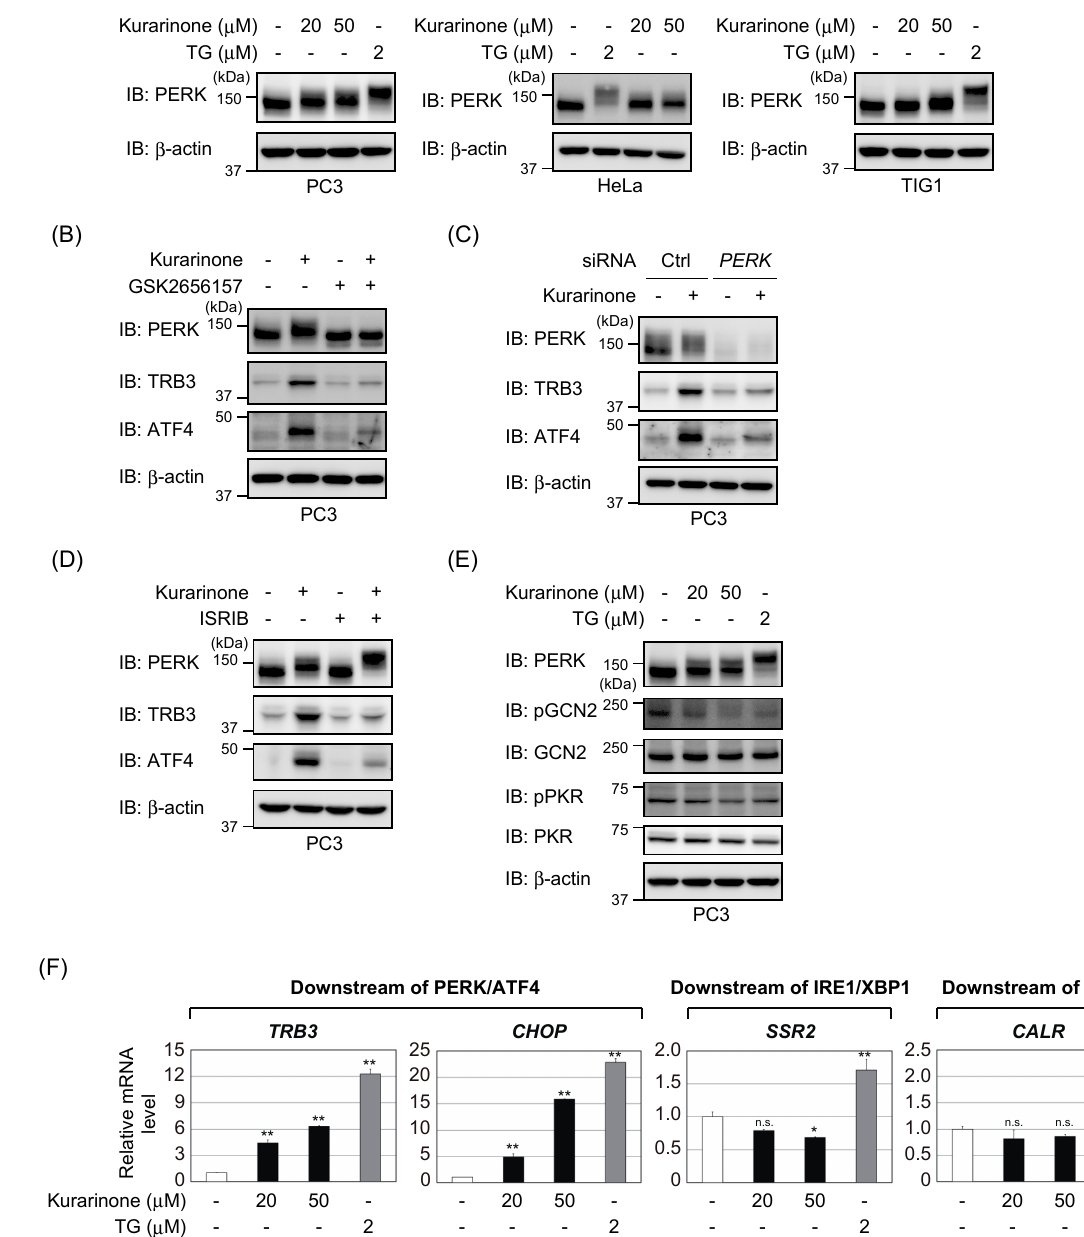
Figure 3. Kurarinone triggers ATF4 activation through the PERK-eIF2 α pathway. ( A ) PC3 cells, HeLa cells, and TIG1 cells were incubated with the indicated doses of thapsigargin (TG) or kurarinone for 6 h. The level of the indicated proteins was determined by immunoblotting. ( B ) PC3 cells were pretreated with 1 µ M of GSK2656157 for 1 h and then incubated with 50 µ M of kurarinone for 6 h. The level of the indicated proteins was determined by immunoblotting as in ( A ). ( C ) PC3 cells were transiently transfected with the indicated siRNAs. After 48 h of transfection, cells were incubated with 50 µ M of kurarinone for 6 h. The level of the indicated proteins was determined by immunoblotting as in ( A ). Ctrl, control. ( D ) PC3 cells were pretreated with 0.5 µ M of ISRIB for 1 h and then incubated with 50 µ M of kurarinone for 6 h. Cell lysates were immunoblotted with the indicated antibodies as in (A). ( E ) PC3 cells were treated with the indicated doses of TG or kurarinone for 6 h. The level of the indicated proteins was determined by immunoblotting as in (A). ( F ) PC3 cells were incubated with the indicated doses of TG or kurarinone for 6 h. The expression level of each gene was assessed by quantitative PCR. Results represent the mean ± S.D. ( n = 3). Significant di ff erences are indicated as ** p < 0.01. * p < 0.05. n.s.: not significant.